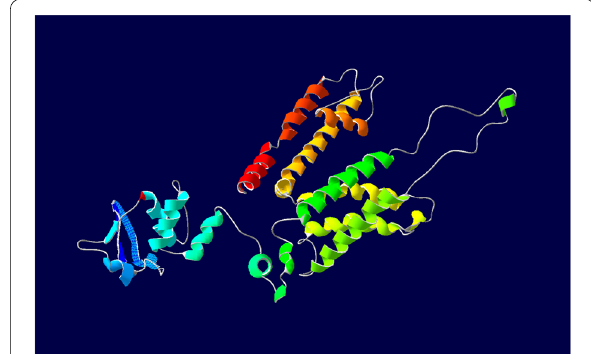
Fig. 5 Protein expression and structure prediction. The mutation occurs in the cytoplasmic N-terminus which is important for tetramerization. Interactions between the different subunits modulate the gating characteristics. The mutation leads to a change in the polarity of the amino acid at the position, which may lead to changes in gating characteristics and ion channel transport efficiency, but the protein function may not be completely